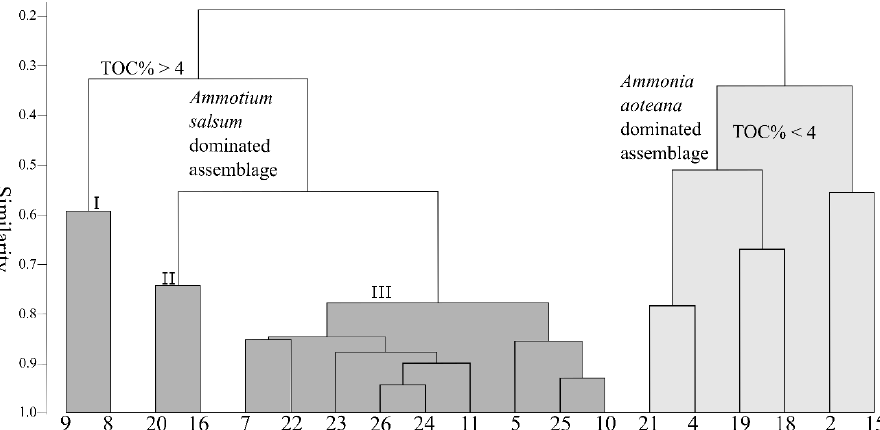
Figure 4. Cluster analysis dendrograms (Bray Curtis coefficient matrix). Q-mode: Q1 = TOC > 4% and Q2 = TOC < 4% (modified after